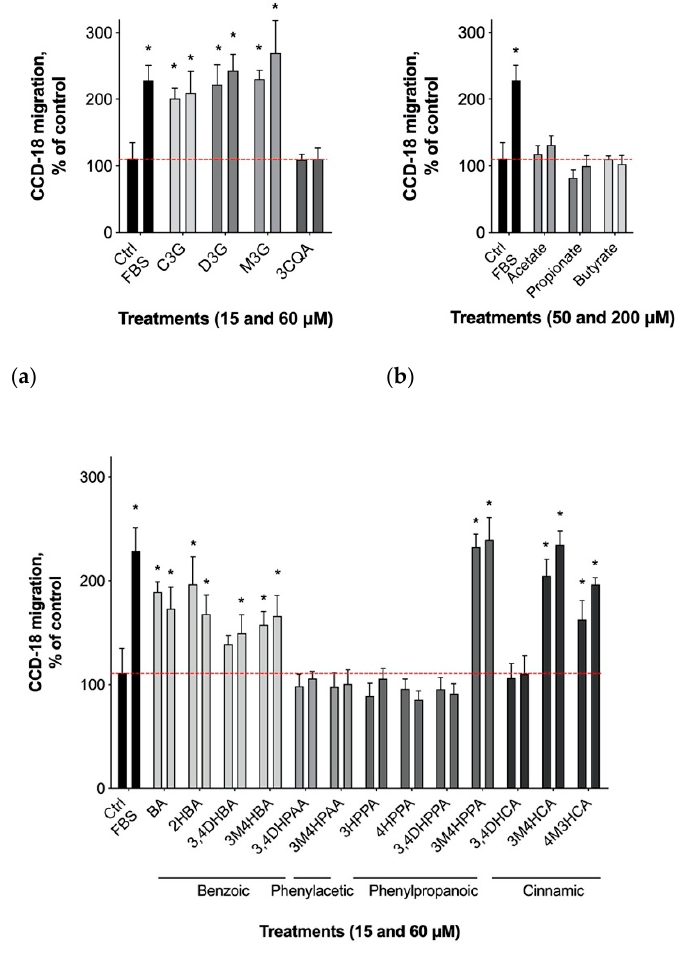
Figure 2. Effects of wild blueberry ( a ) anthocyanin glucosides, ( b ) short-chain fatty acid metabolites from dietary fiber, and ( c ) different subclasses of phenolic acid metabolites on CCD-18 gastrointestinal epithelial cell migration. Cells were seeded in Oris migration plates and their migration into exclusion zones was followed for 48 h with/without the indicated treatments and compared against the vehicle (0.1% DMSO) and positive control (20% FBS). Pre- and post-migration central fluorescence was quantified by NucBlue (Hoechst 33342) staining at 360 nm excitation/460 nm emission and reported as mean ± SEM (* p < 0.05). Anthocyanin and phenolic acids were tested at 15 µ M (lower dose) and 60 µ M (higher dose); short-chain fatty acids were tested at 50 µ M (lower dose) and 200 µ M (higher dose), as indicated on each panel.